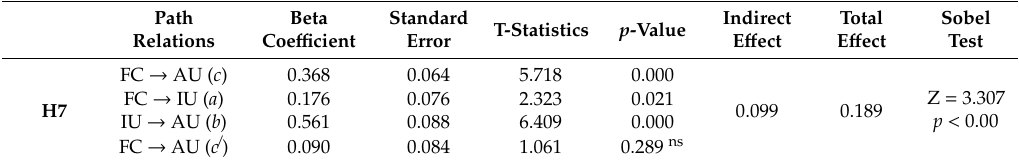
Table 4. Mediating e ff ect